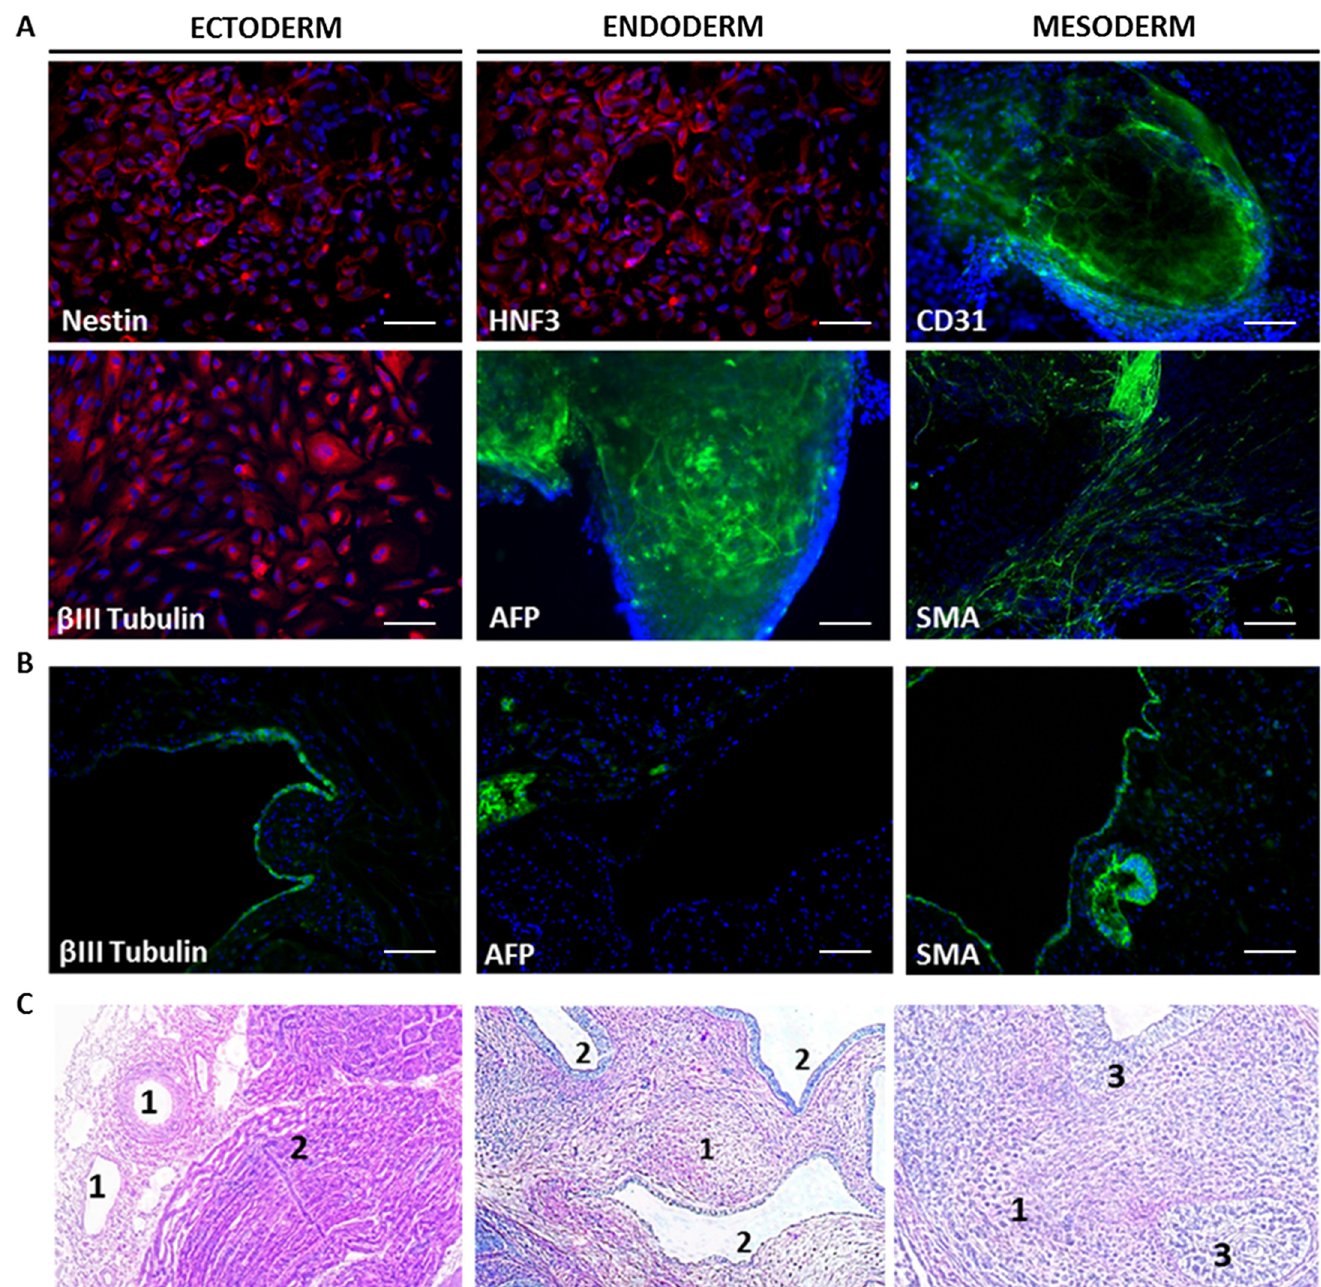
Fig 4. Pluripotency of ECFC-derived iPSCs. (A) Immunostaining of iPSC-derived embryoid bodies revealed the expression of ectodermal ( β III tubulin, nestin), endodermal (AFP, HNF-3 β ), mesodermal (CD31, SMA) markers. Nuclei were stained with DAPI. Scale bars represent 100 μ m. (B) Immunostaining of teratomas induced in SCID mice after injection of 100,000 ECFC-derived iPSC1 containing derivatives of the 3 germ layers differentiation ( β III tubulin, AFP and SMA). Nuclei were stained with DAPI. Scale bars represent 100 μ m. (C) Histology of teratomas (hematoxylin/eosin staining) confirming differentiation into all 3 germ layers: mesoderm (1) endoderm (2) and ectoderm (3).